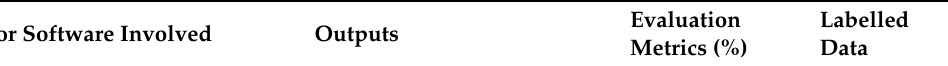
Table 6. Combination of sensors used in different research